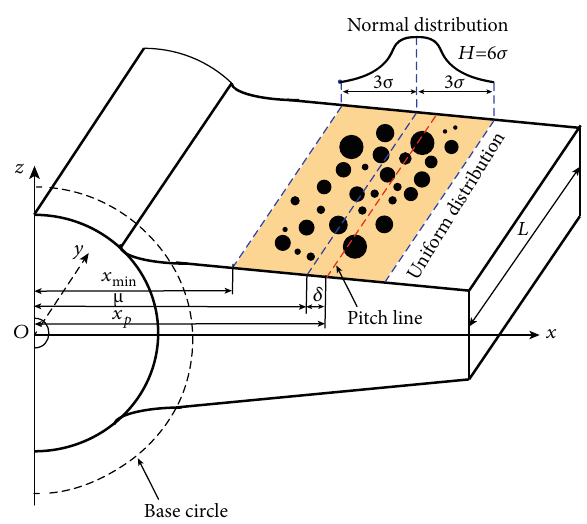
Figure 2: Distribution of pits on the tooth